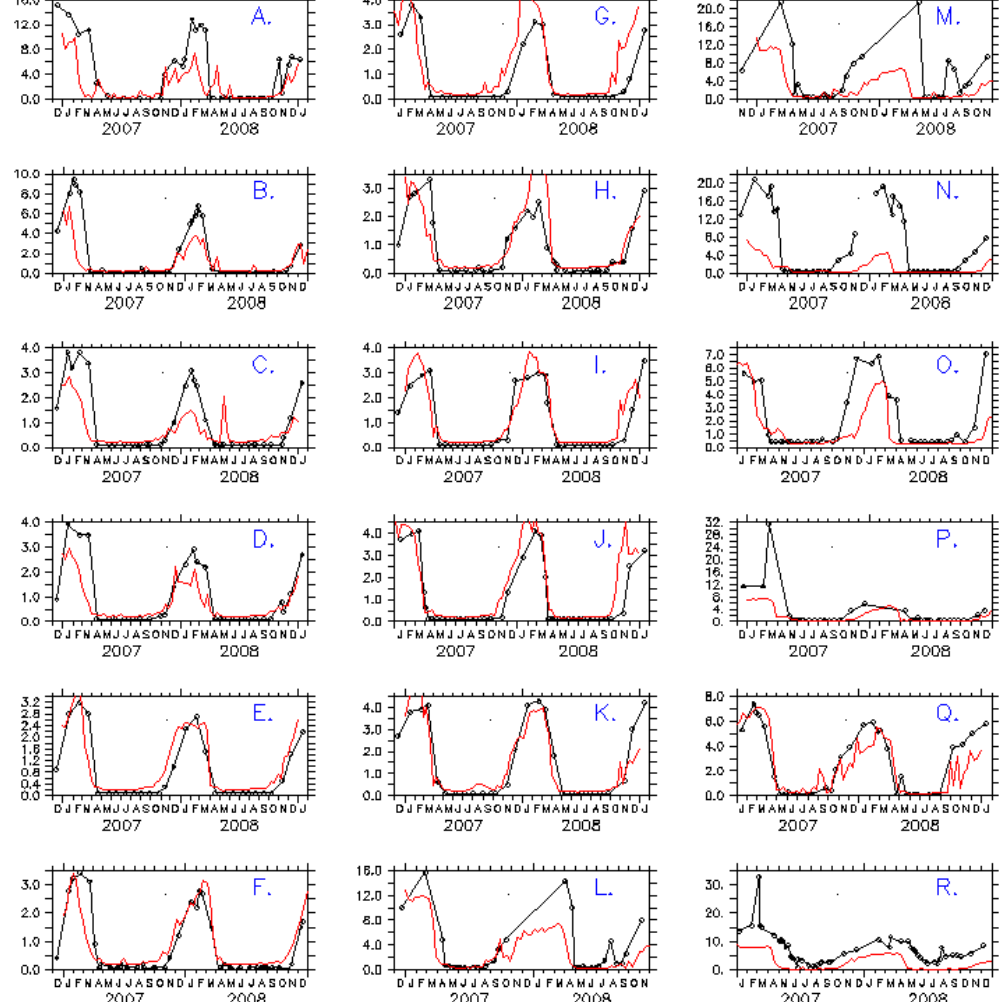
Fig. 6. Seasonal variability of DIN in surface layer. Red solid curve (black dashed cycles) for model results (observations). Unit: mmolm − 3 . Panels (A–R) for Stations A–R (Fig. 1),